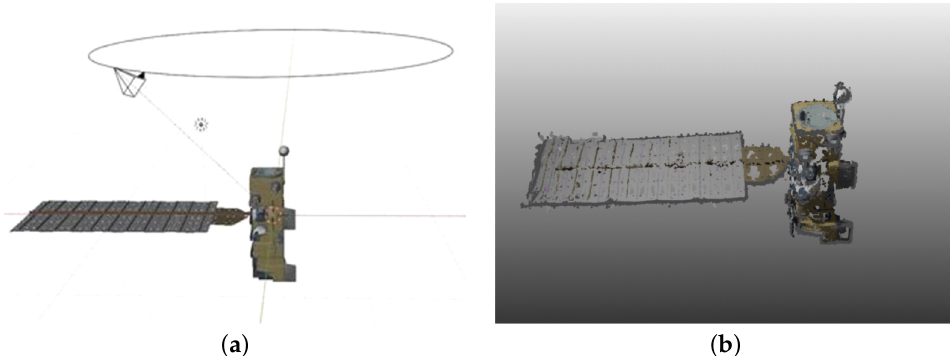
Figure 4. Blender simulation system: ( a ) Blender simulation platform. ( b ) Simulation visual point cloud.